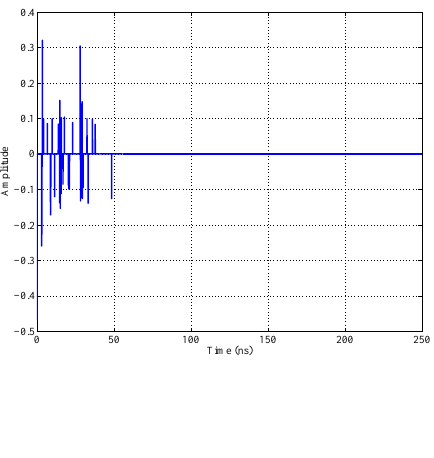
Figure 31. Time domain channel derived from VNA measurement. The sparsity of this channel is